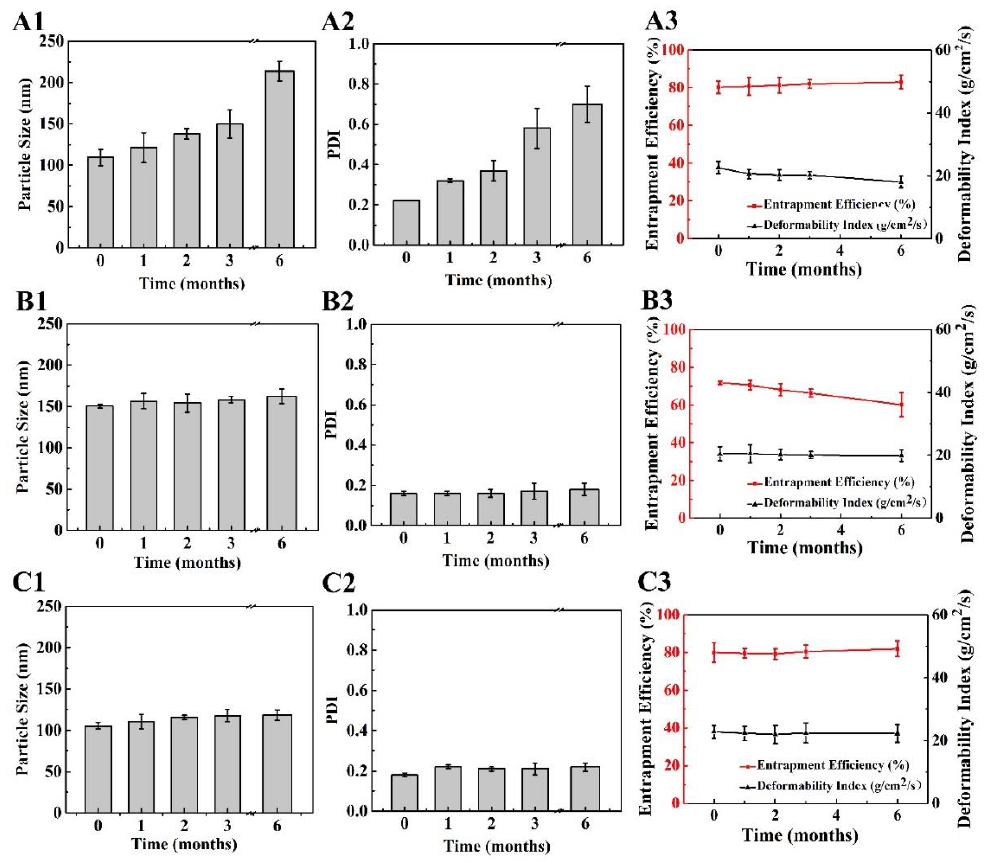
Figure 7. Changes in lyophilized deformable nanovesicles after storage at 25 °C for a period of 6 months. ( A ) 8%-T, ( B ) 8%-L, and ( C ) 8%-L-T, 1 particle size, 2 PDI , 3 entrapment efficiency (EE) and deformability index (DI).